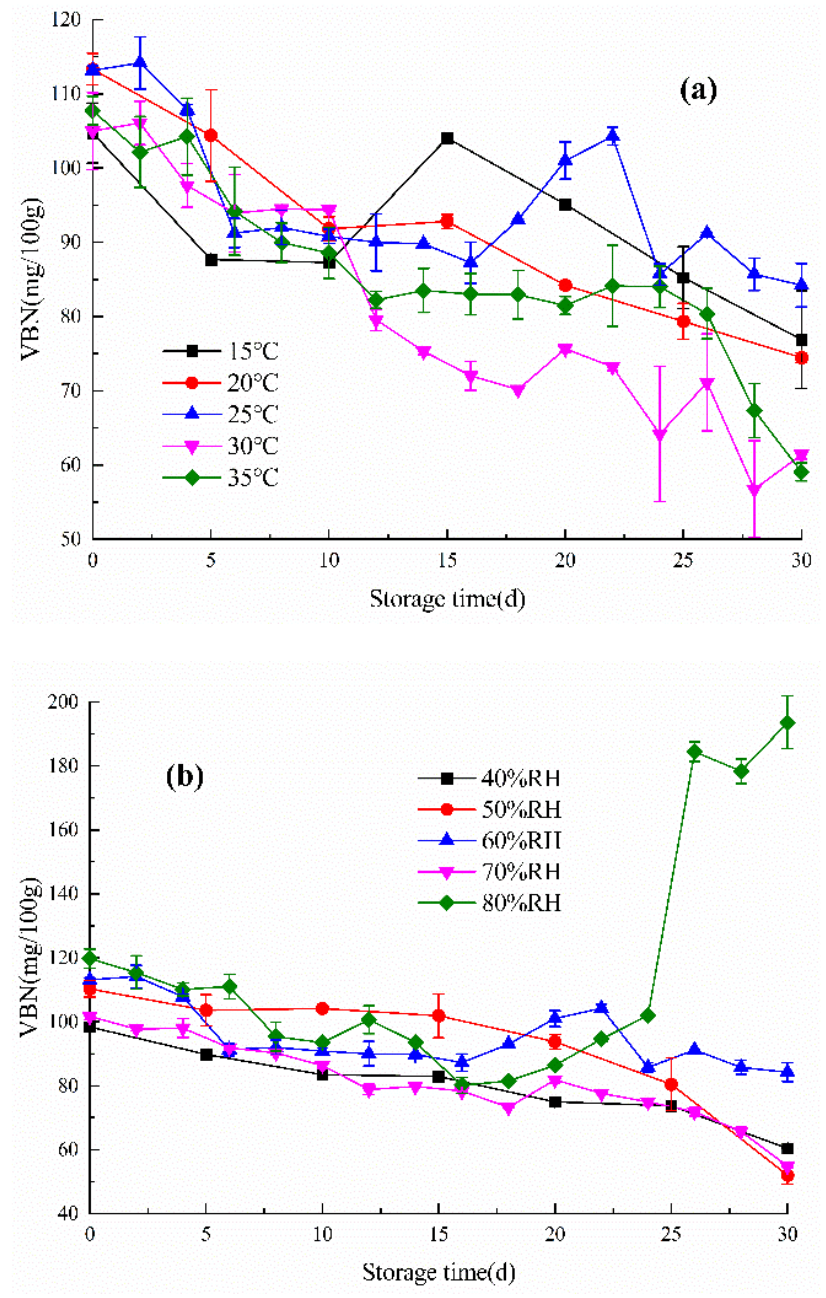
Figure 2. The trend for the VBN of fishmeal: ( a ) at 15 ◦ C, 20 ◦ C, 25 ◦ C, 30 ◦ C, and 35 ◦ C; ( b ) at 40% RH, 50% RH, 60% RH, 70% RH, and 80% RH.